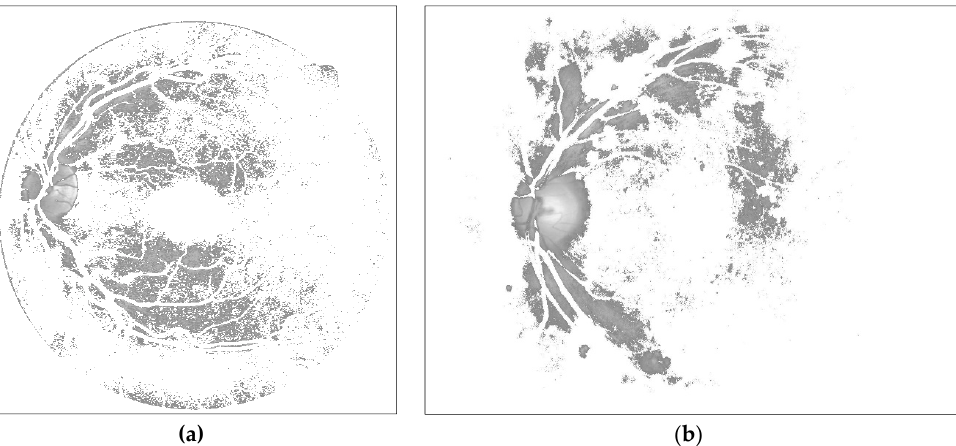
Figure 6. Images consisting of pixels remaining above the specified threshold. ( a ) is a healthy retinal image; ( b ) is a diseased retinal image.